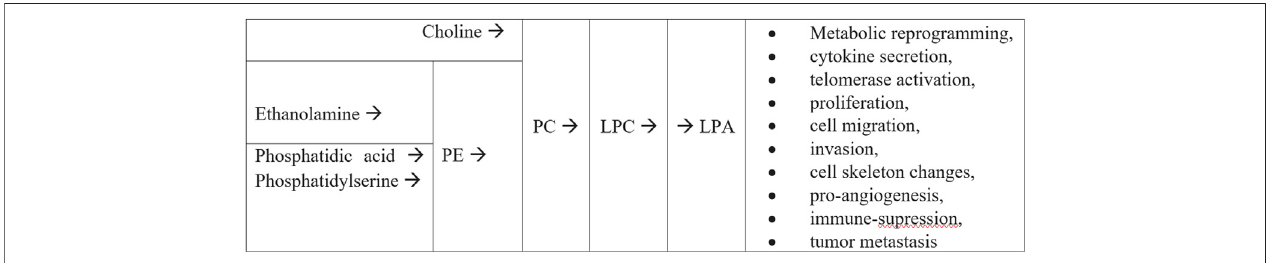
FIGURE3| TheKennedypathway( denovo synthesisofPE,PCandLPAfromcholineandphosphatidicacid)presentingthepotentialroleofglycerophospholipids metabolism on cancerogenesis (according to Plewa et al. (Plewa et al., 2019)).